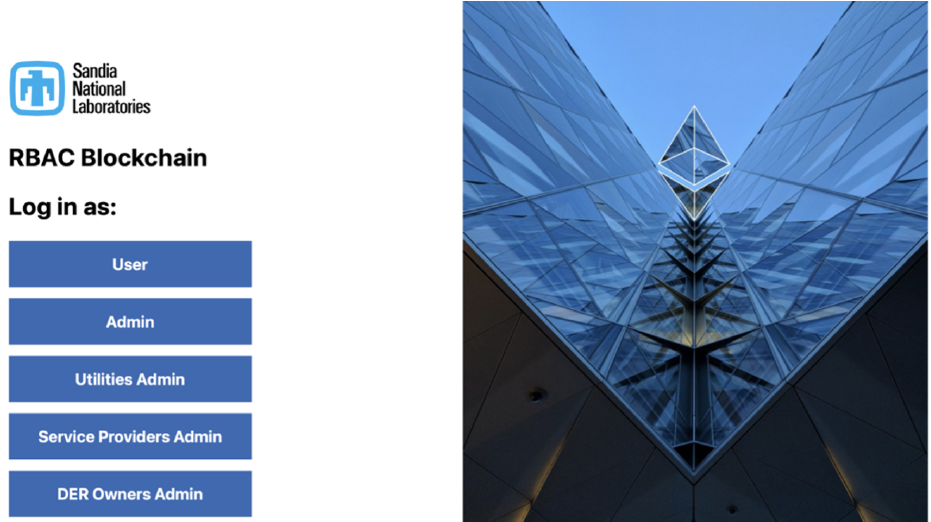
Figure 3. Ethereum Blockchain GUI: A user can determine how they want to login into the system (User or